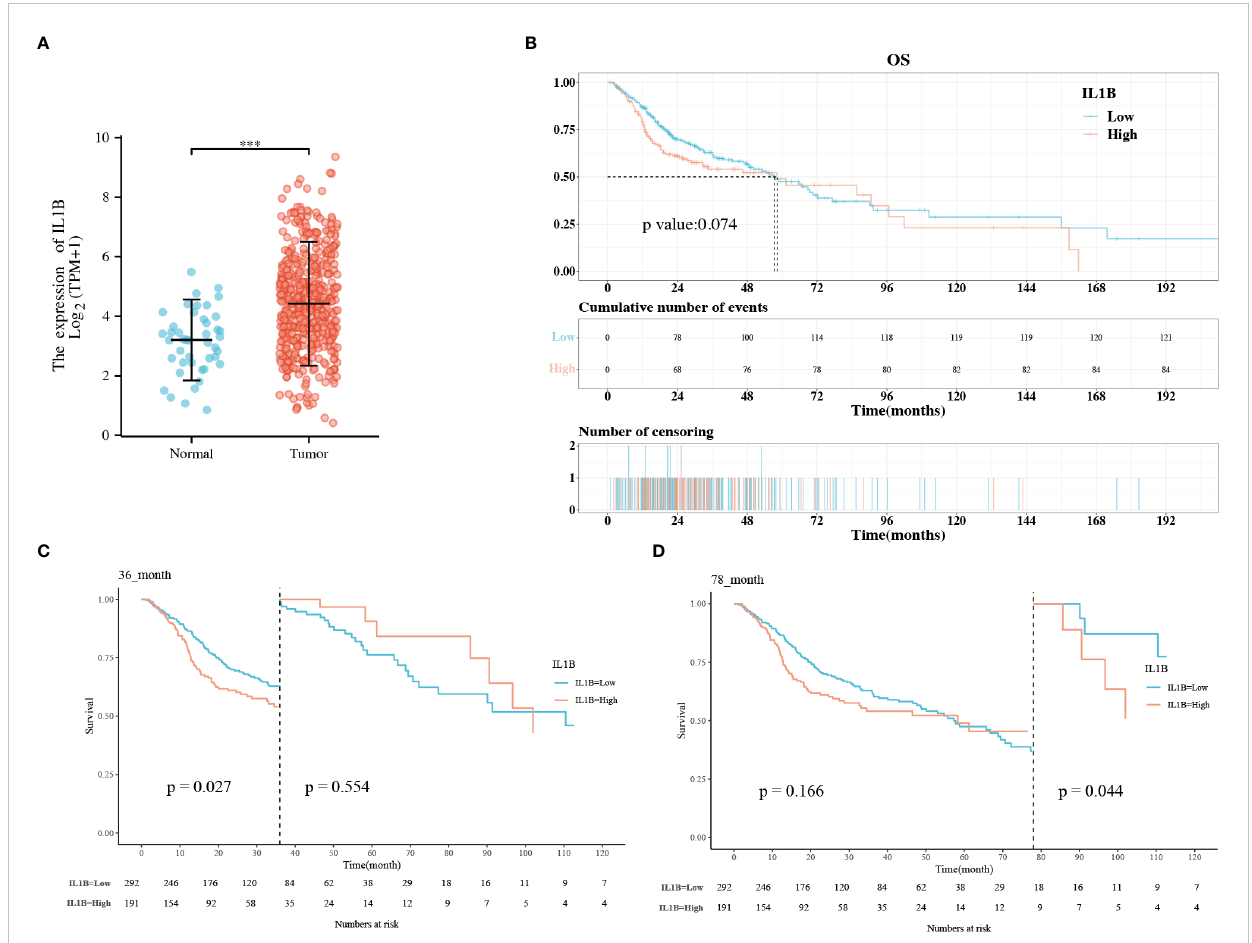
FIGURE 2 The correlation analysis between IL1B expression level and OS of patients with HNSCC. (A) The expression level of IL1B in HNSCC group and normal group; (B) The KM analysis of IL1B high- and low-expression groups; (C, D) The landmark analysis of IL1B high- and low-expression group. OS, overall survival; KM, Kaplan –